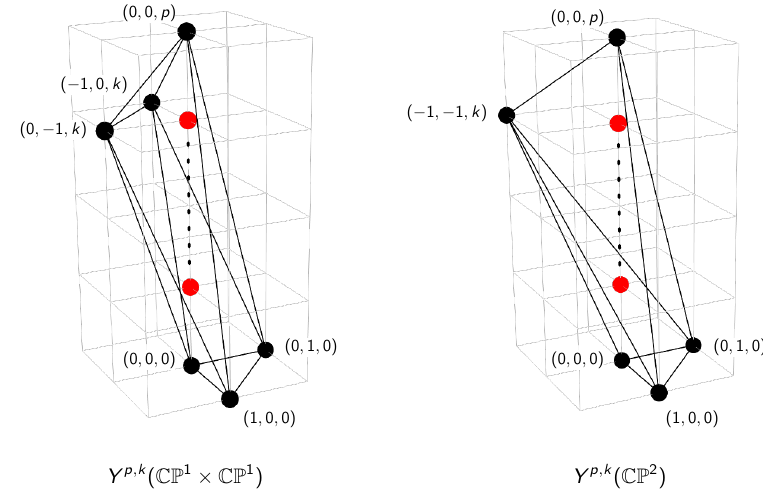
Figure 1 . General toric diagrams corresponding to the Y p,k ( CP 2 ) and Y p,k ( CP 1 × CP 1 ) families of toric CY 4-folds. The ranges for the parameters p and k are summarized in